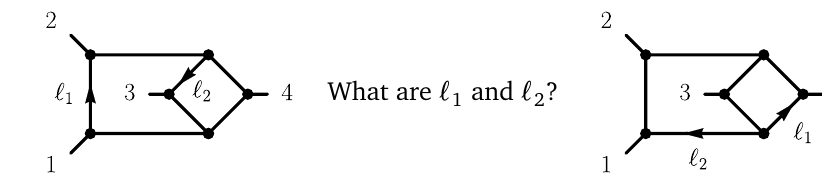
Figure 1: Ambiguity in labeling loop momenta in a given contribution to the inte-